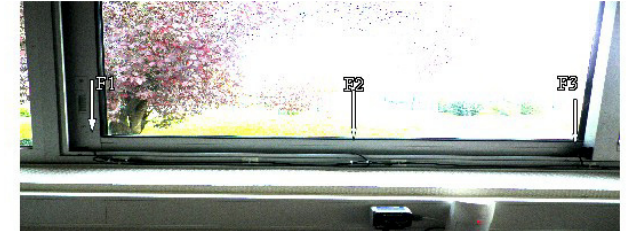
Fig. 8. Windows monitoring dry contact sensors position.